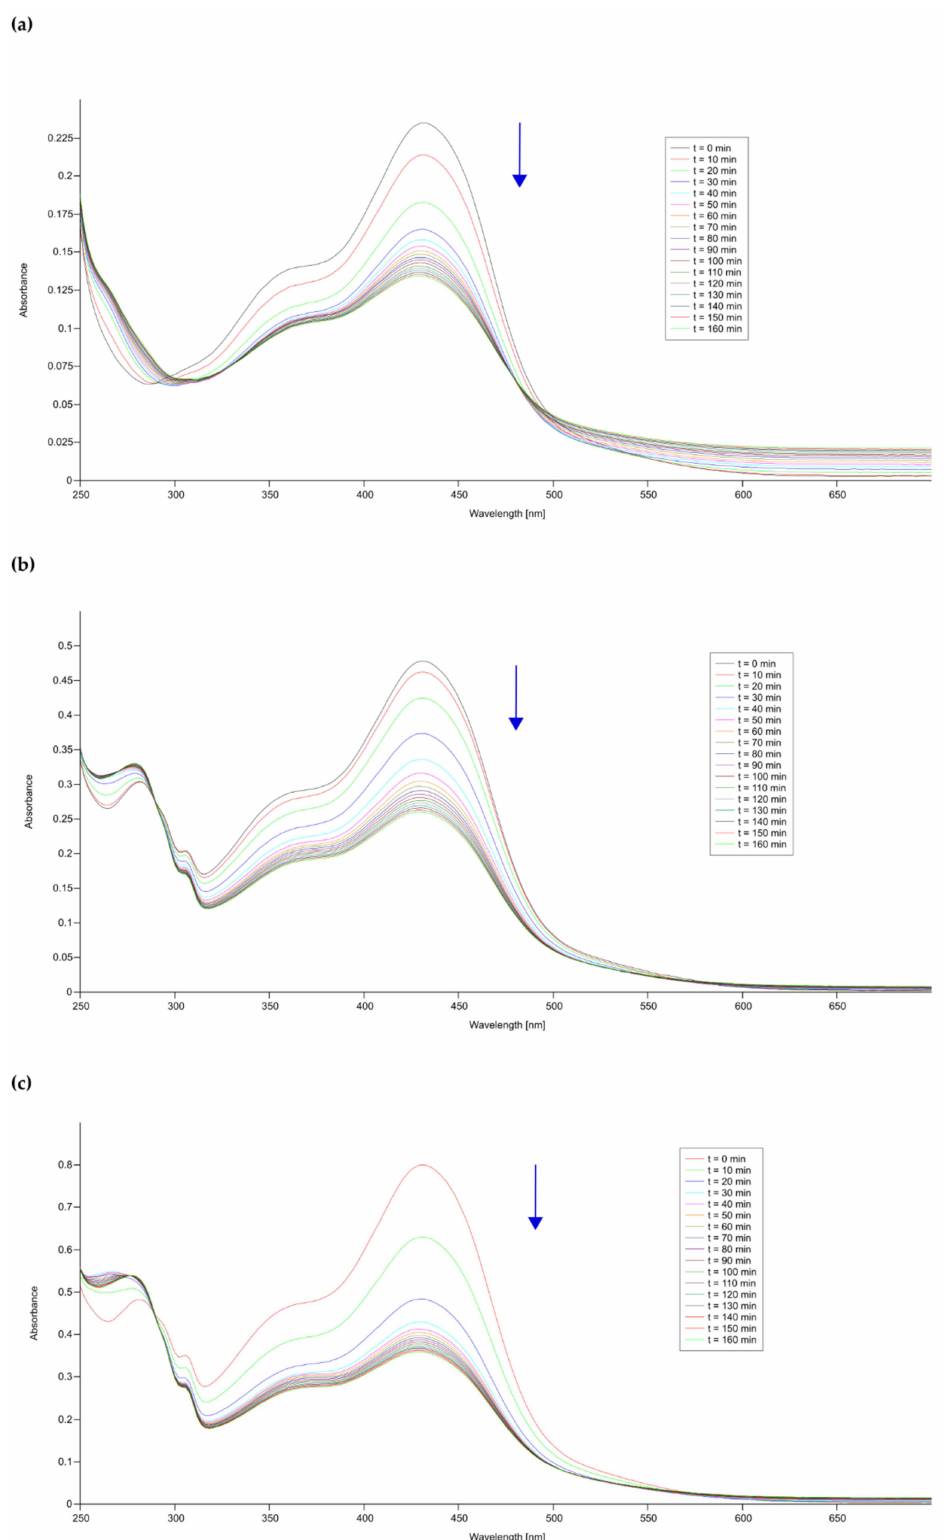
Figure 8. Time-dependent UV-vis spectra of ( a ) curH, ( b ) 1 , and ( c ) 2 in 90 vol.% phosphate bu ff ered saline (PBS, pH = 7.2) + 10 vol.% DMSO